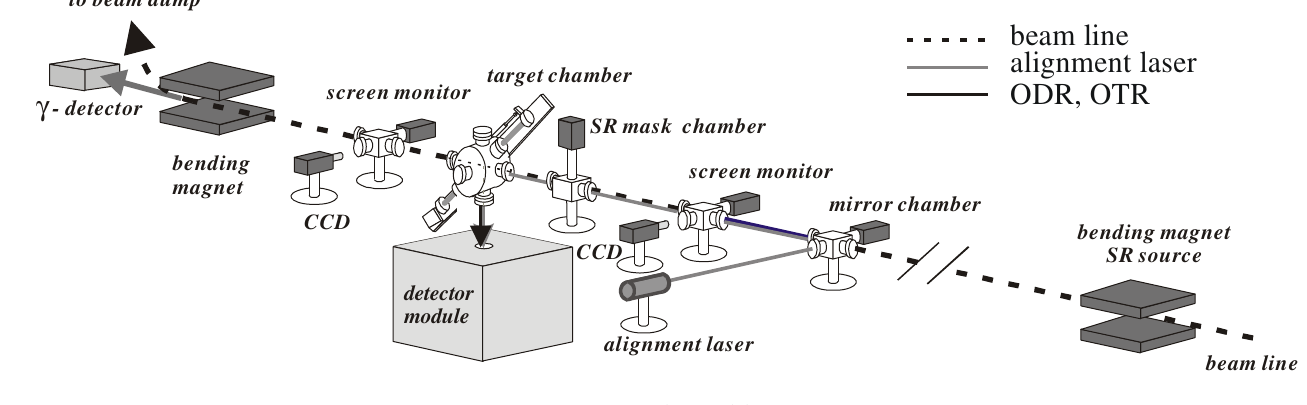
FIG. 8. Experimental layout.